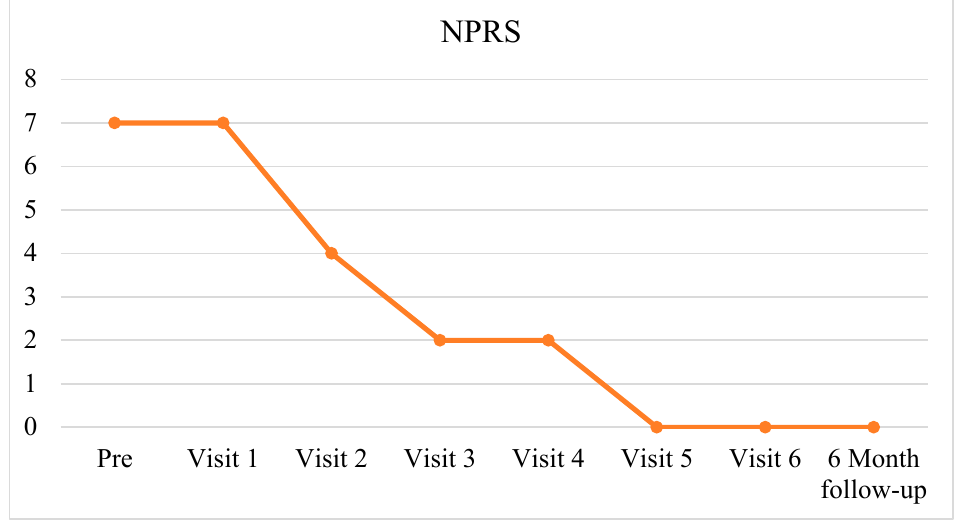
Figure 1. Self-reported low back pain rating (NPRS).